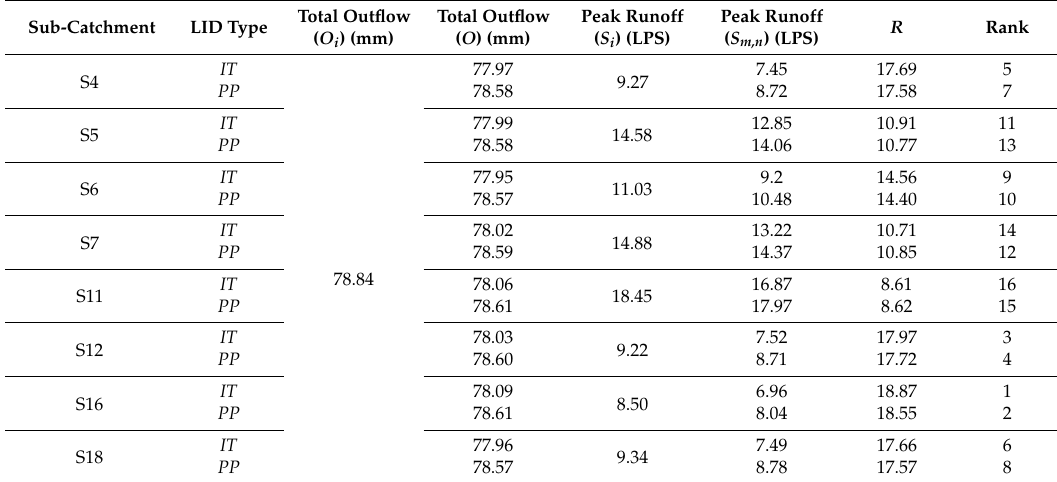
Figure 4. Comparison of peak and total runoff using WMPM. Table 5. Comparison of peak runoff by WMPM.